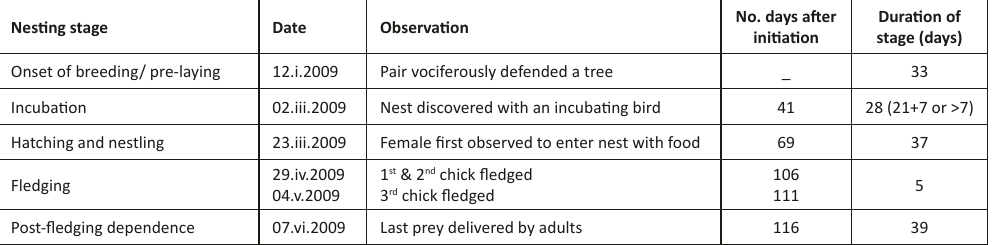
No. days after initiation